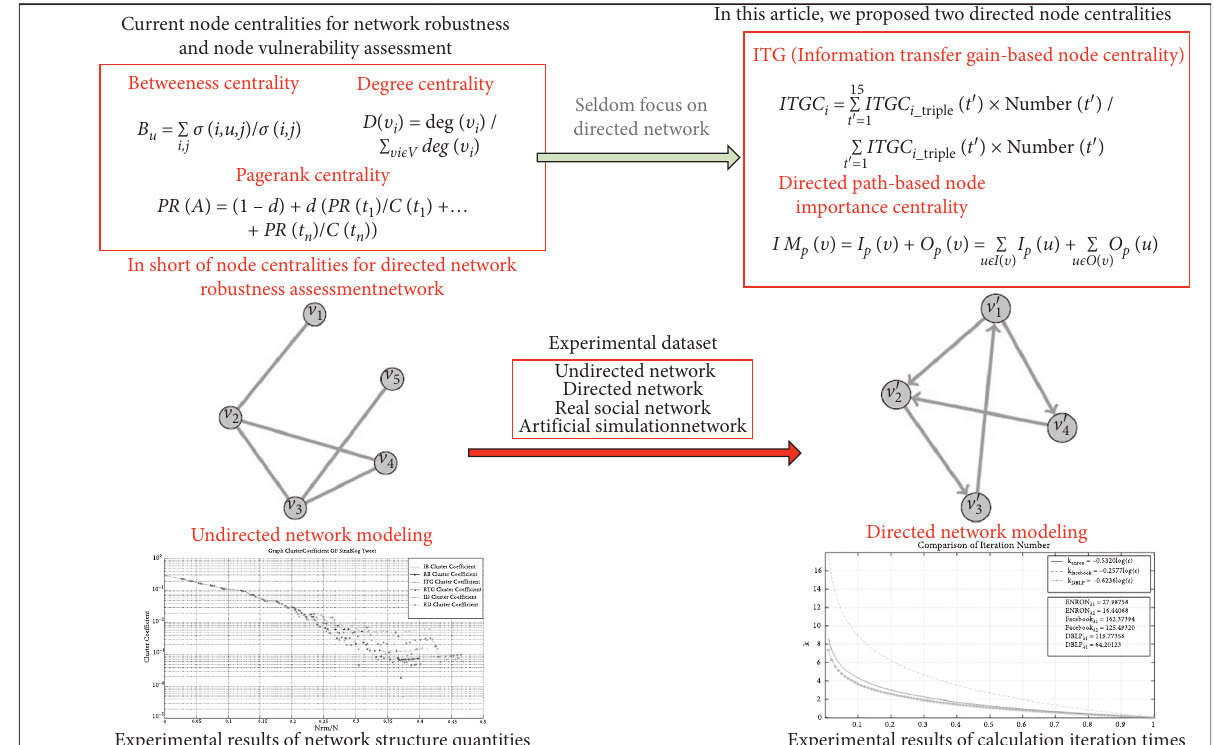
Figure 1: Toy example